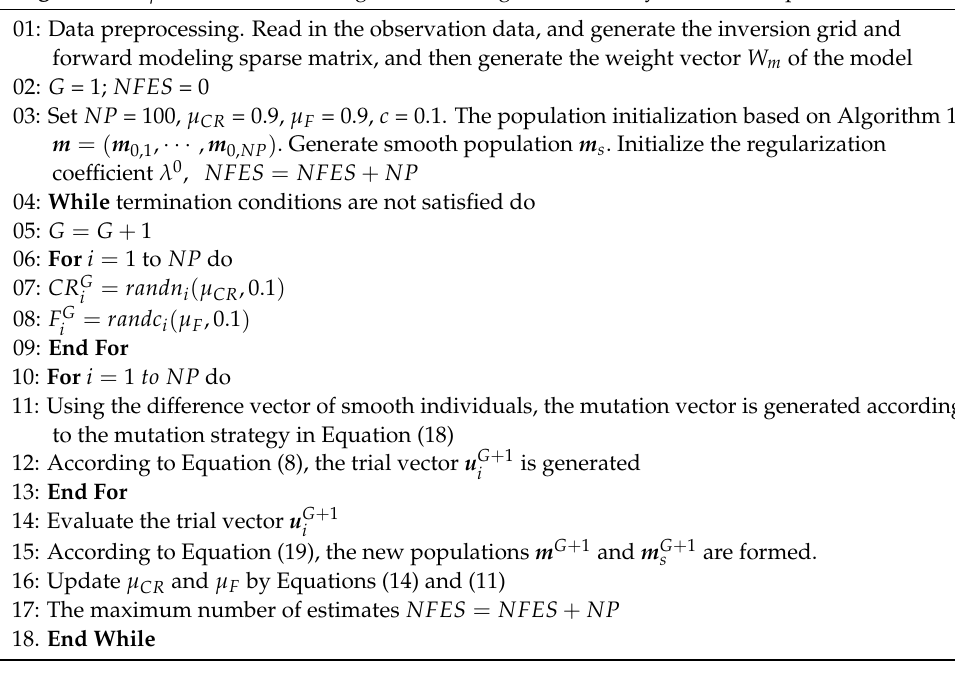
Algorithm 2 l p Norm Inversion Algorithm of Magnetic Anomaly Based on Improved